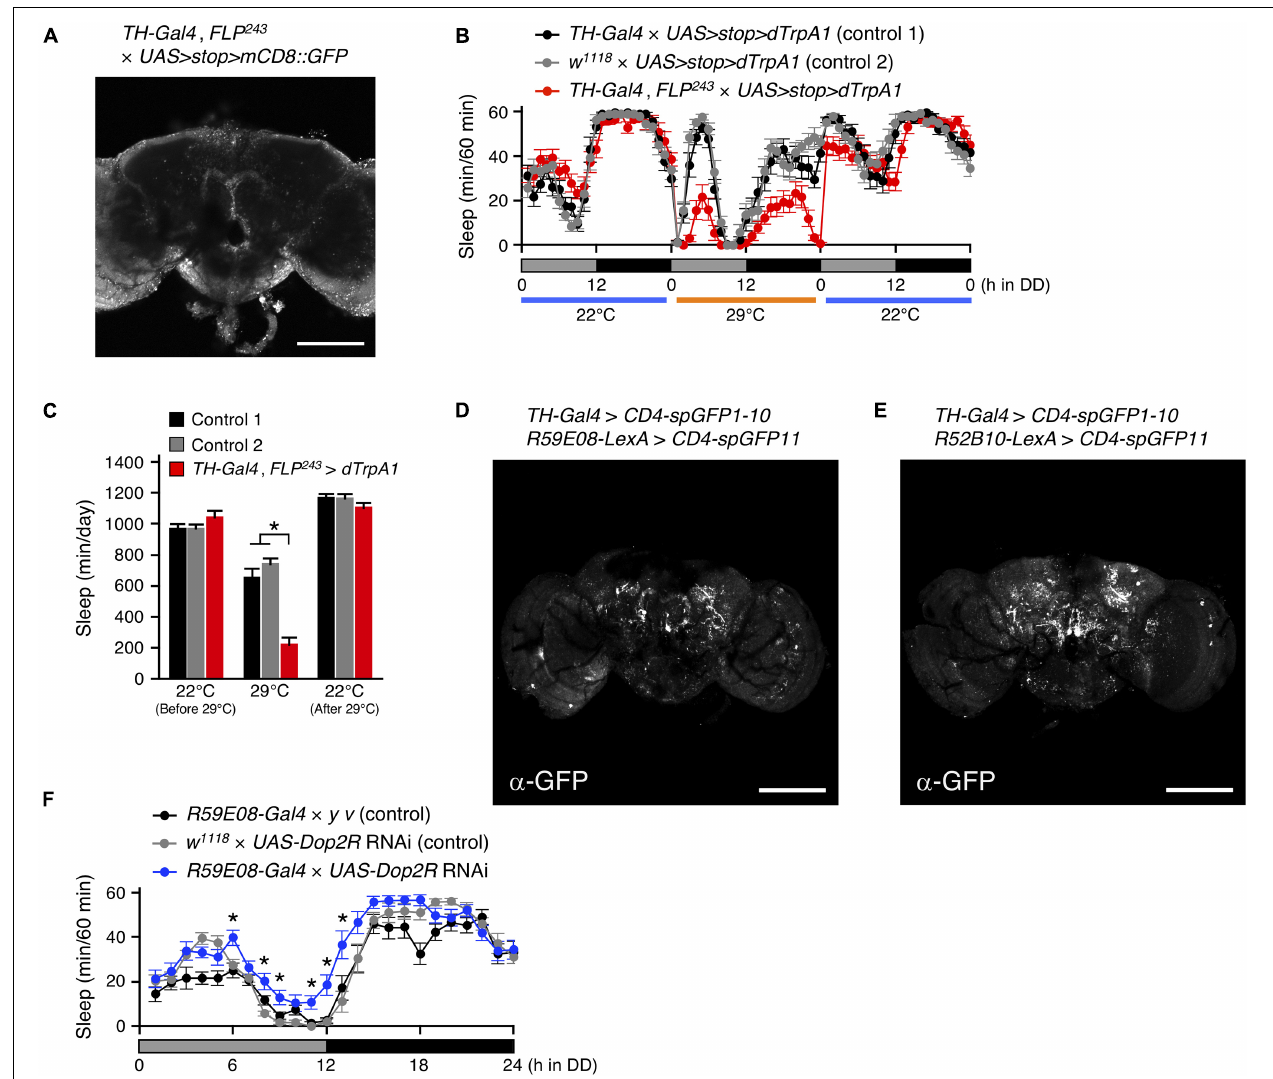
FIGURE 7 | Dopamine regulates sleep by acting on the sleep-promoting PB interneurons. (A) Maximum-intensity projection of the confocal brain images of TH-Gal4 , FLP 243 crossed to UAS > stop > mCD8::GFP flies. TH-Gal4 , FLP 243 restricts expression to the T1 dopaminergic (DA) neurons that project to the PB. Scale bar indicates 100 µ m. (B,C) Sleep profiles in 60-min intervals (B) or total daily sleep (C) for controls [ TH-Gal4 × UAS > stop > dTrpA1 (control 1), black circles or bars, n = 16; w 1118 × UAS > stop > dTrpA1 (control 2), gray circles or bars, n = 16] or flies expressing dTrpA1 in T1 DA neurons ( TH-Gal4 , FLP 243 × UAS > stop > dTrpA1 , red circles or bars, n = 16) in DD conditions. The behavior was monitored as described in Figure 2 . Data are presented as mean ± SEM. * p < 0.05; two-way repeated measures ANOVA with the Holm-Bonferroni method for multiple comparisons. (D,E) The anatomical connection of DA neurons in TH-Gal4 to the sleep-promoting PB interneurons (D) or the wake-promoting PFN neurons (E) were examined using the GRASP method. Brains were stained with a reconstituted GFP-specific antibody. Scale bars indicate 100 µ m. (F) Sleep profiles in 60-min intervals for controls ( R59E08-Gal4 × y v , black circles, n = 16; w 1118 × UAS-Dop2R RNAi, gray circles, n = 16) and Dop2R RNAi-expressing flies using the R59E08-Gal4 driver (blue circles, n = 16) in DD conditions. Data are presented as mean ± SEM. * p < 0.05 vs. both controls; two-way repeated measures ANOVA with the Holm-Bonferroni method for multiple